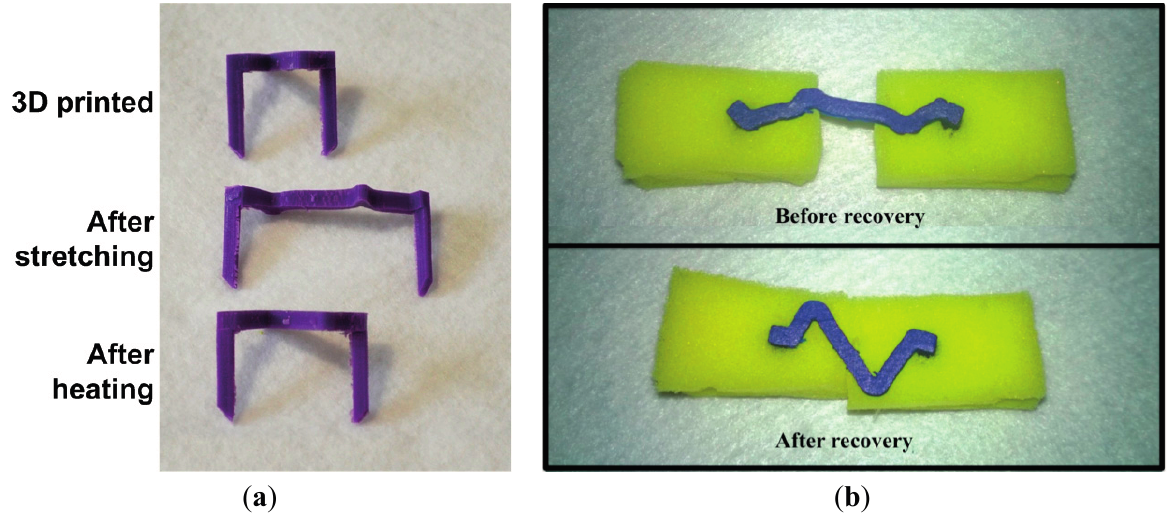
Figure 12. 3D printed PLA staple with self-tightening function. ( a ) The SME in staple; and ( b ) demonstration of tightening function, before and after heating for shape